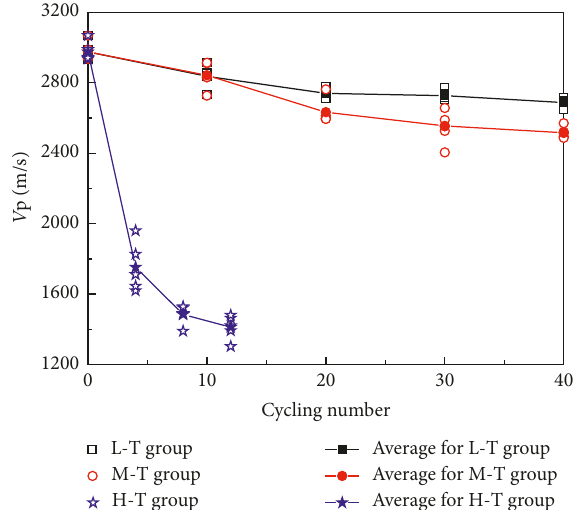
Figure 5: Test results of P-wave velocity for different groups before and after H-C cycles.